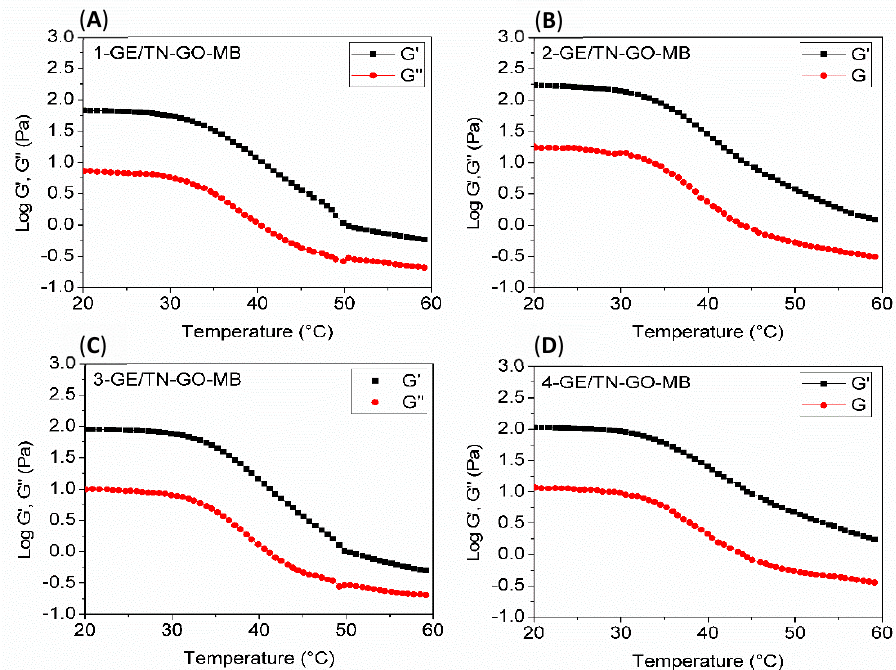
Figure 3. G’ and G’’ as a function of the oscillatory frequency for GE/TN-GO-MB systems with different GO content (Table 1) at 37 °C. ( A ) 1-GE/TN-GO-MB; ( B ) 2-GE/TN-GO-MB; ( C ) 3-GE/TN- GO-MB; and ( D ) 4-GE/TN-GO-MB.